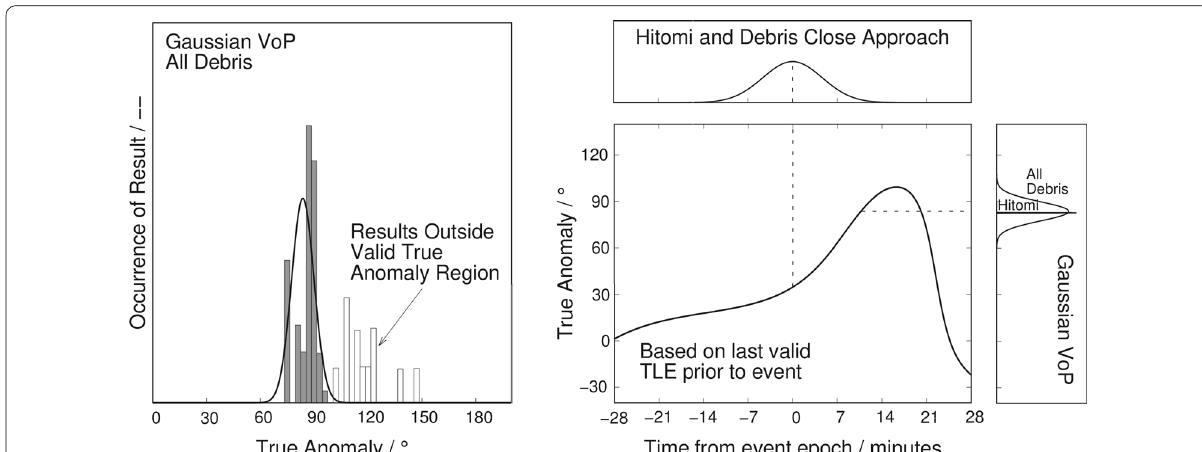
Fig. 3 Left Histogram of results from solving of Gaussian variation of parameters equations based on the last viable TLE before the event and five TLEs for each fragment (except for the two which decayed within a few days of the event). Right True anomaly of Hitomi predicted using SGP4 based on the last viable TLE before for the event. Normal probability density functions are given from close approach analysis for event time and from Gaussian VoP analysis for event true anomaly. The dotted lines indicate the mean values from the normal probability density functions